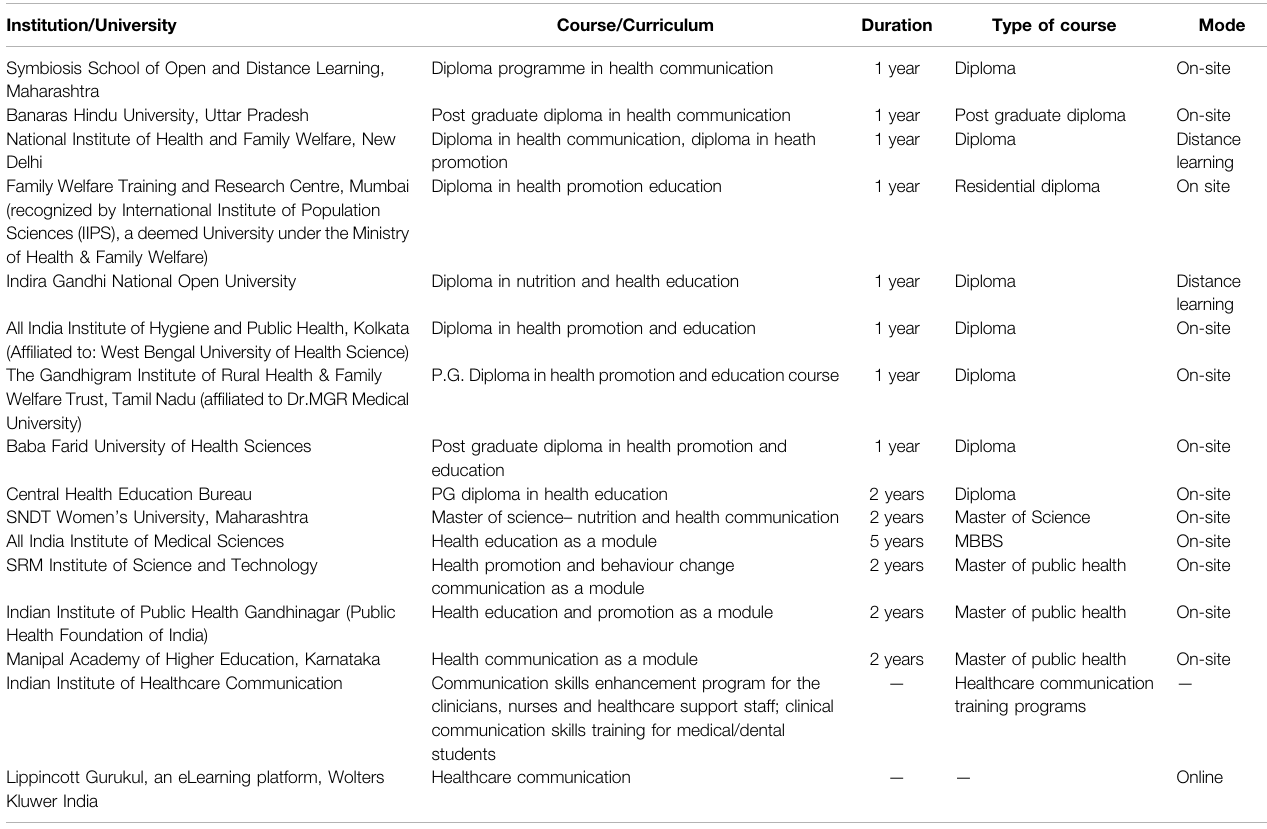
TABLE 1 | Overview of courses related to health communication, promotion and education offered in India a